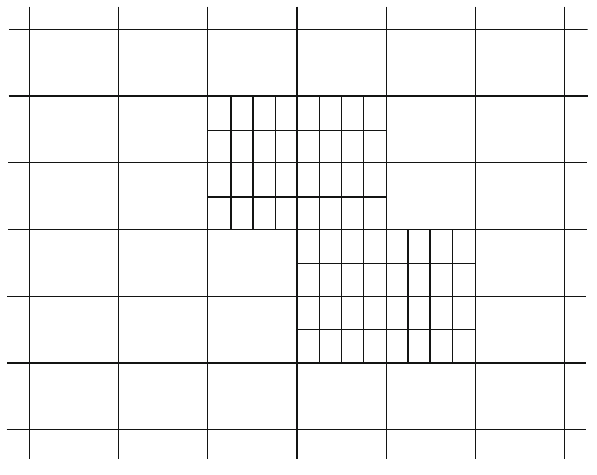
Figure 6: Grid re fi nement in Cartesian coordinate.